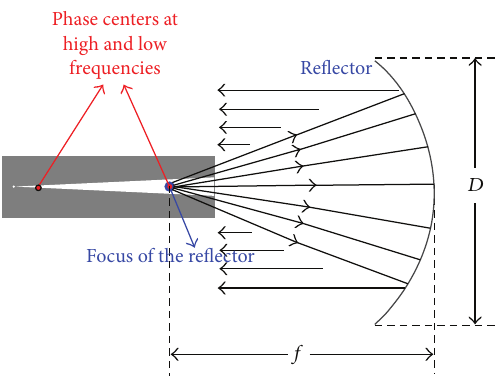
Figure 1: Phase centers of an UWB antenna at high and low frequencies.